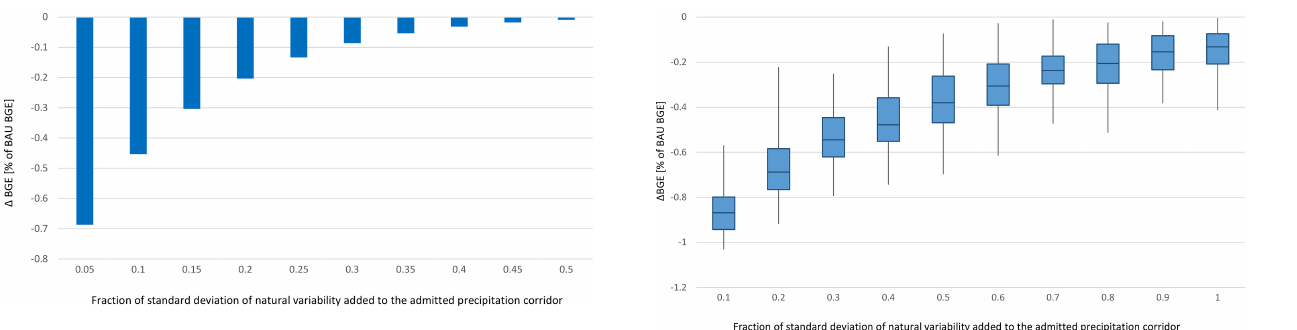
Figure 7. Sensitivity analysis on the fraction of standard deviation of natural variability added to the admitted precipitation corridor. The extra admissible range is increased from 5% of the standard deviation of natural variability to 50% of the standard deviation of natural variability. The leftmost two bars (0.05 and 0.1) correspond to the G0 5% and G0 10% in Fig. 5.